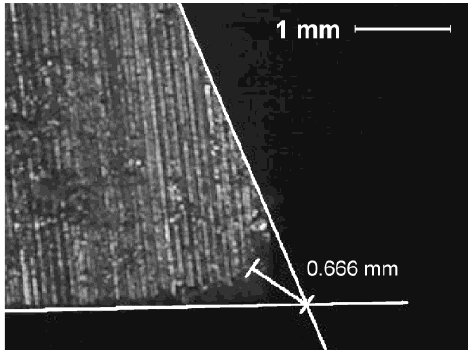
Figure 6. Measurement of the direct wear indicator.